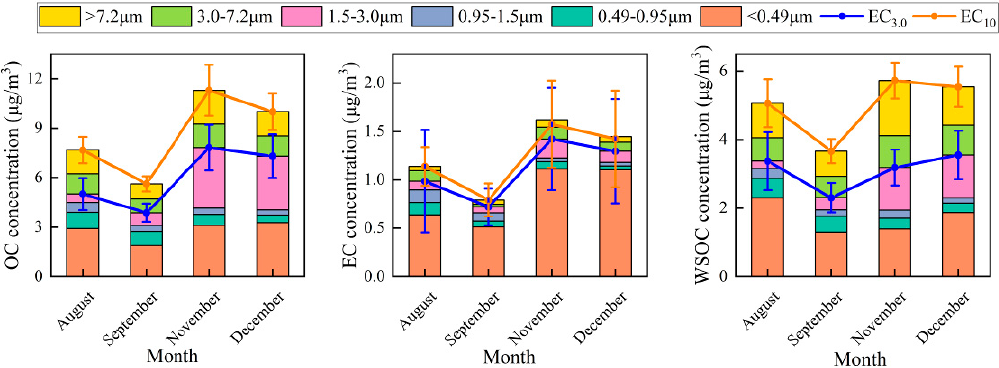
Figure 4. Temporal variations of organic carbon (OC), elemental carbon (EC), and water-soluble organic carbon (WSOC) concentrations in the size-segregated aerosols during the sampling period.